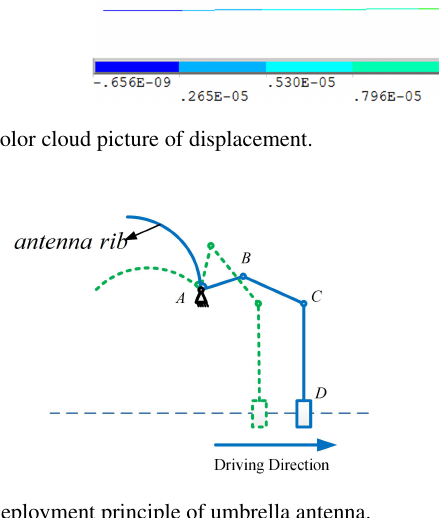
Figure 9. Deployment principle of umbrella antenna.